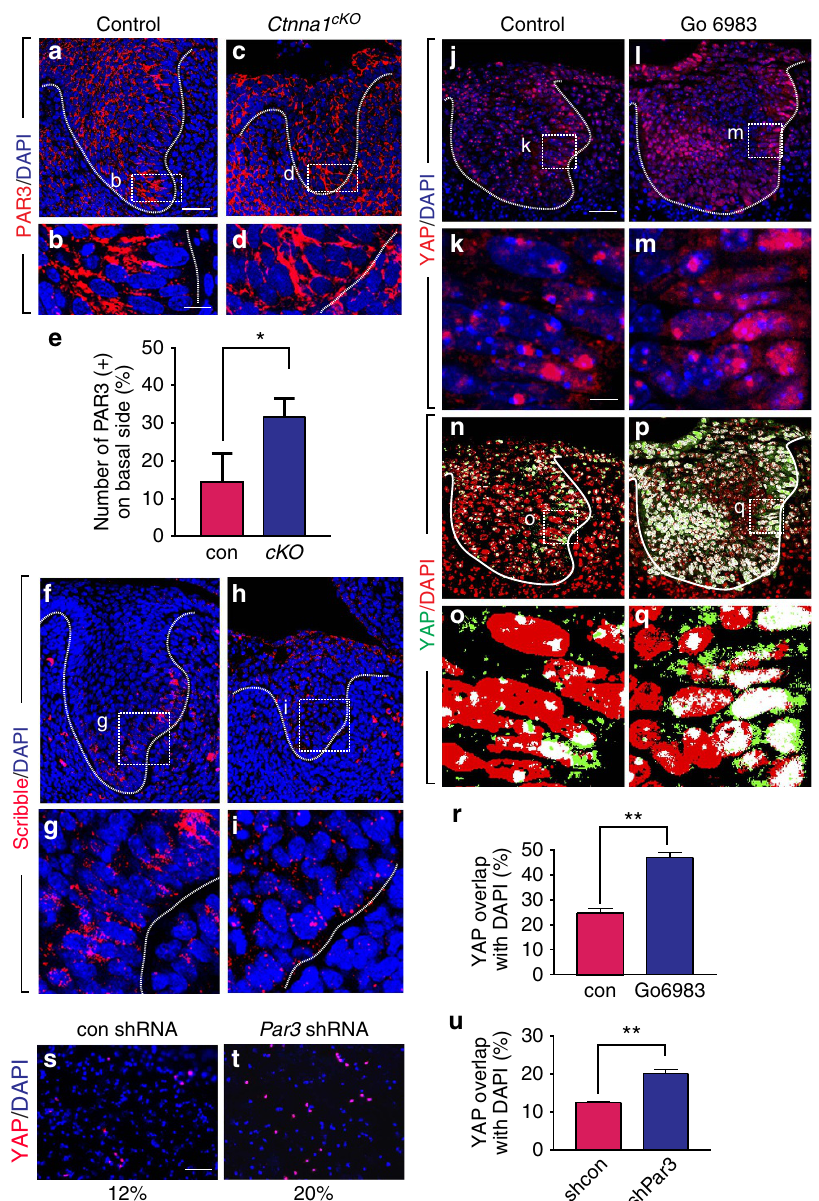
Figure 2 | a E-catenin is required for maintaining proper cell polarity in the tooth germ epithelium. ( a , b ) PAR3 is apically localized in cells of the basal layer at E13.5. ( c , d ) Deletion of Ctnna1 causes basal mislocalization of PAR3. ( e ) Quantification of the cells with mislocalized PAR3 in basal layers of control and Ctnna1 cKO tooth germs (mean ± s.e.m., n ¼ 3, P o 0.05). ( f , g ) Scribble is laterally localized in the basal layer at E13.5. ( h , i ) The level of Scribble protein is decreased after ablation of a E-catenin. ( j – q ) Inhibition of aPKC with Go¨ 6983 induces nuclear localization of YAP in the explant culture. ( r ) Quantification of nuclear YAP in vehicle and antagonist treated tissues (mean ± s.e.m., n ¼ 3, P o 0.01). ( s , t ) Knockdown of PAR3 with shRNA induces YAP nuclear localization in primary epithelial cells. ( u ) Quantification of nuclear YAP in control (shcon) and shRNA (shPar3)-treated cells (mean ± s.e.m., n ¼ 3, P o 0.01). All quantifications are analysed by using Student’s t -test. * P o 0.05, ** P o 0.01. Dotted lines outline the epithelium of the incisor tooth germ.